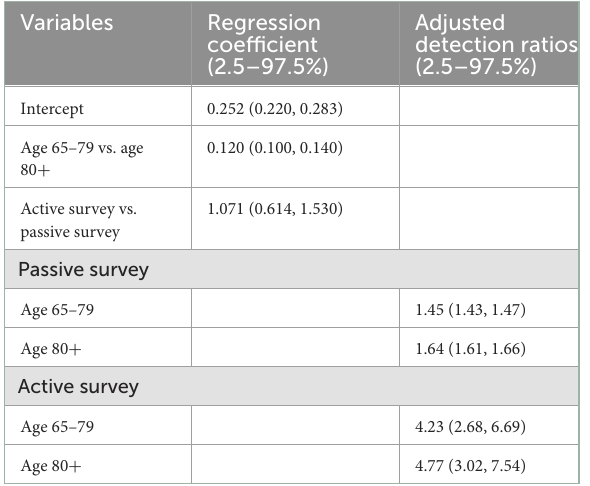
TABLE 3 Adjusted detection ratios of dementia measured by passive survey.